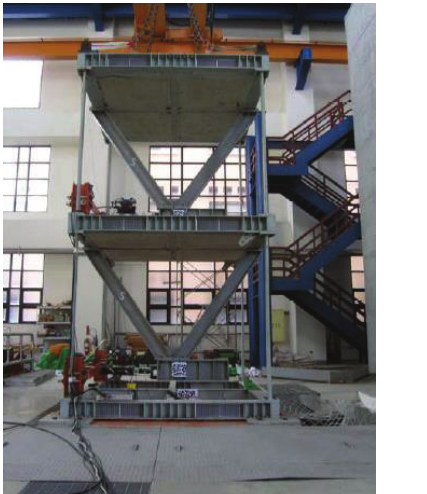
Figure 3: The shaking table test for ASHD as AIC with various control conditions.